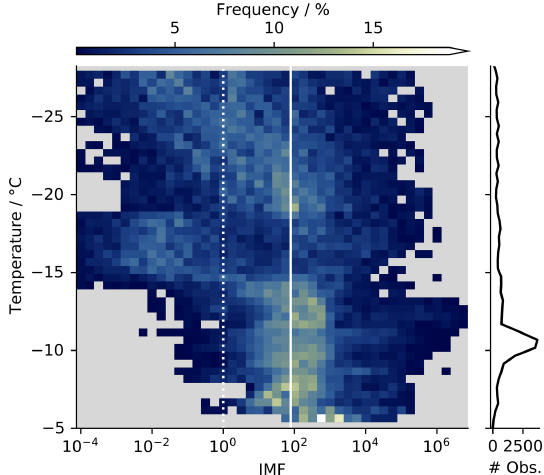
Figure 12. Frequency histogram of all observed ice multiplication factors (IMFs) above cloud base combined with altitude. Frequen- cies are normalized to the number of observations (right axis) per height bin. Gray background indicates where no ice crystal number concentration data were observed. The dashed white line indicates an IMF of unity. The median IMF of all data is indicated in solid white.